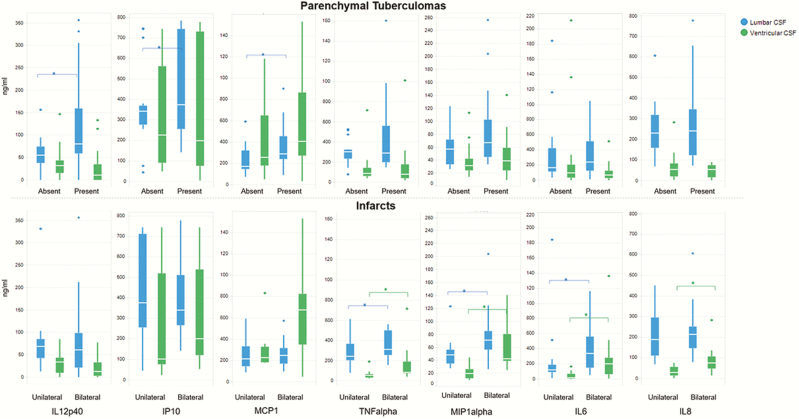
Association between overall radiology and inflammatory marker concentrations. These box and whisker plots demonstrate the median, interquartile range, and range of the highest inflammatory marker concentrations in lumbar and ventricular cerebrospinal fluid (CSF) for various radiologic features recorded across admission and in-hospital follow-up scans (overall computed tomography and magnetic resonance imaging). Statistically significant results are indicated by a square bracket and *. Each row represents the data for individual cytokines (interleukin [IL] 12p40, interferon-inducible protein 10 [IP-10], monocyte chemoattractant protein 1 [MCP-1], tumor necrosis factor alpha [TNF-α], macrophage inflammatory protein 1-alpha [MIP-1α], IL-6, and IL-8) in the presence of parenchymal tuberculomas (top panel) or infarcts (bottom panel).